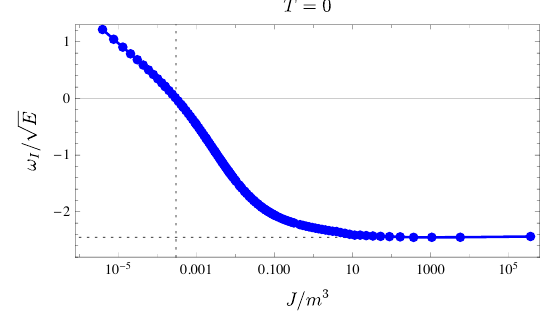
Figure 9 . Asymptotic behavior of the pure-imaginary mode for large J/m 3 at T = 0 . The horizontal axis is shown in log scale. The vertical dotted line shows J/m 3 = J (1) √ −√ line shows ω I / E = 6 , which is the analytic value in the massless limit m = 0 .